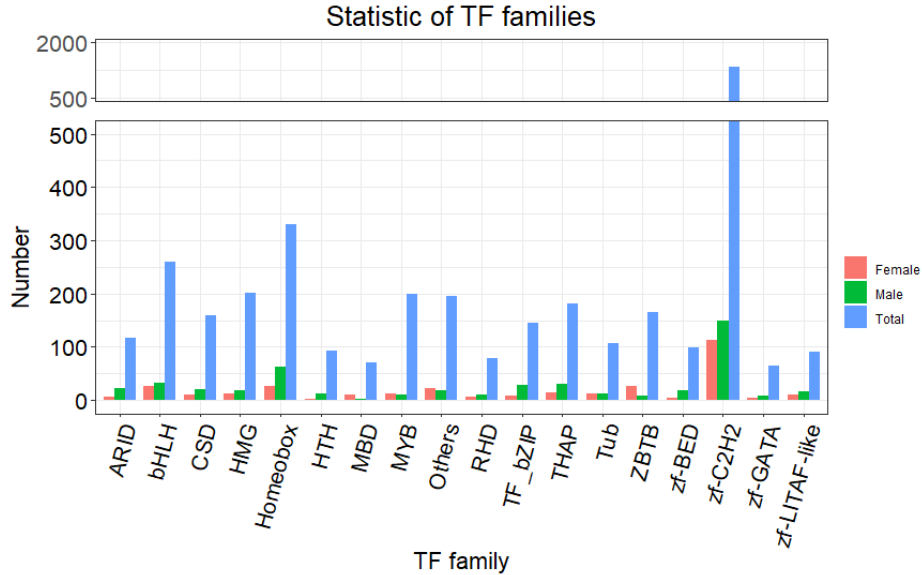
Figure 7. Analysis of the total and deferentially expressed transcription factors. The blue column indicates the TFs identified in this work, the red column indicates TFs expressed higher in female and the green column indicates TFs expressed higher in male.